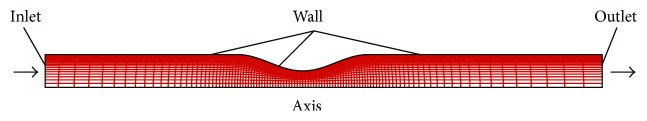
Computational grids and boundary conditions of the η = 0.75 case.